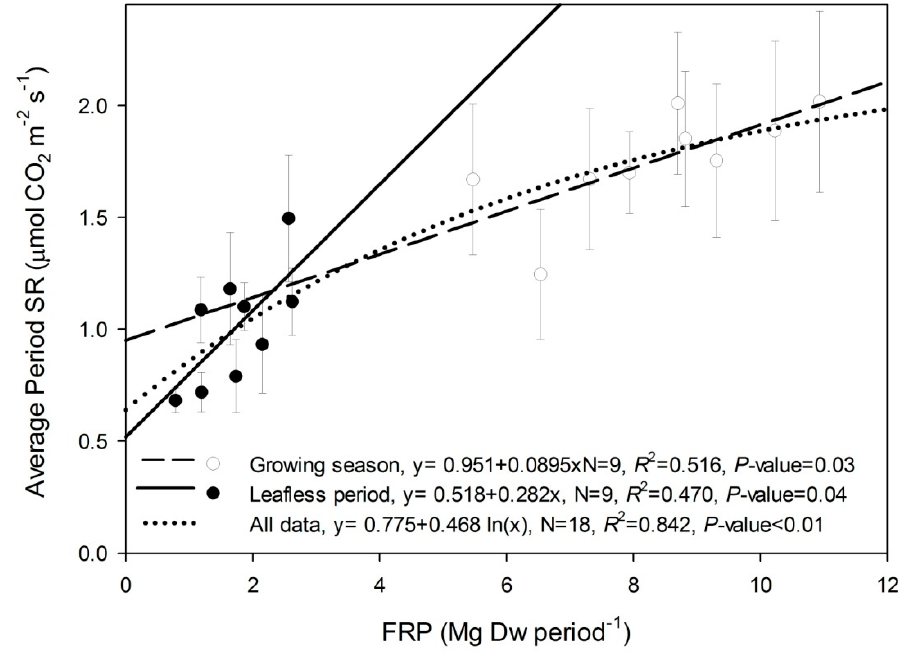
Figure 4. Relationship between fine root production (FRP) and mean soil CO 2 efflux (SR) in different periods of the study: from May 2007 to October 2007 (FRP G , dashed line and empty circles); from November 2007 to April 2008 (FRP LP , continuous line and black circles); dotted line shows overall relationship. Each point is a different sampling plot, and error bars represent standard deviation.